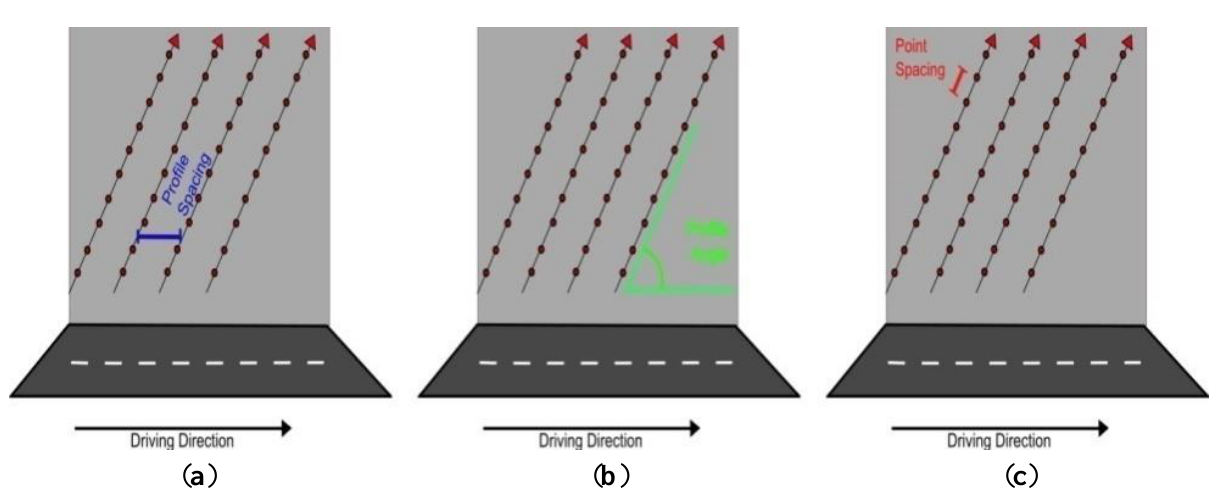
Figure 2. A corkscrew scan pattern intersecting with a vertical surface results in three distinctive features ( a ) profile spacing ( b ) profile angle and ( c ) the point